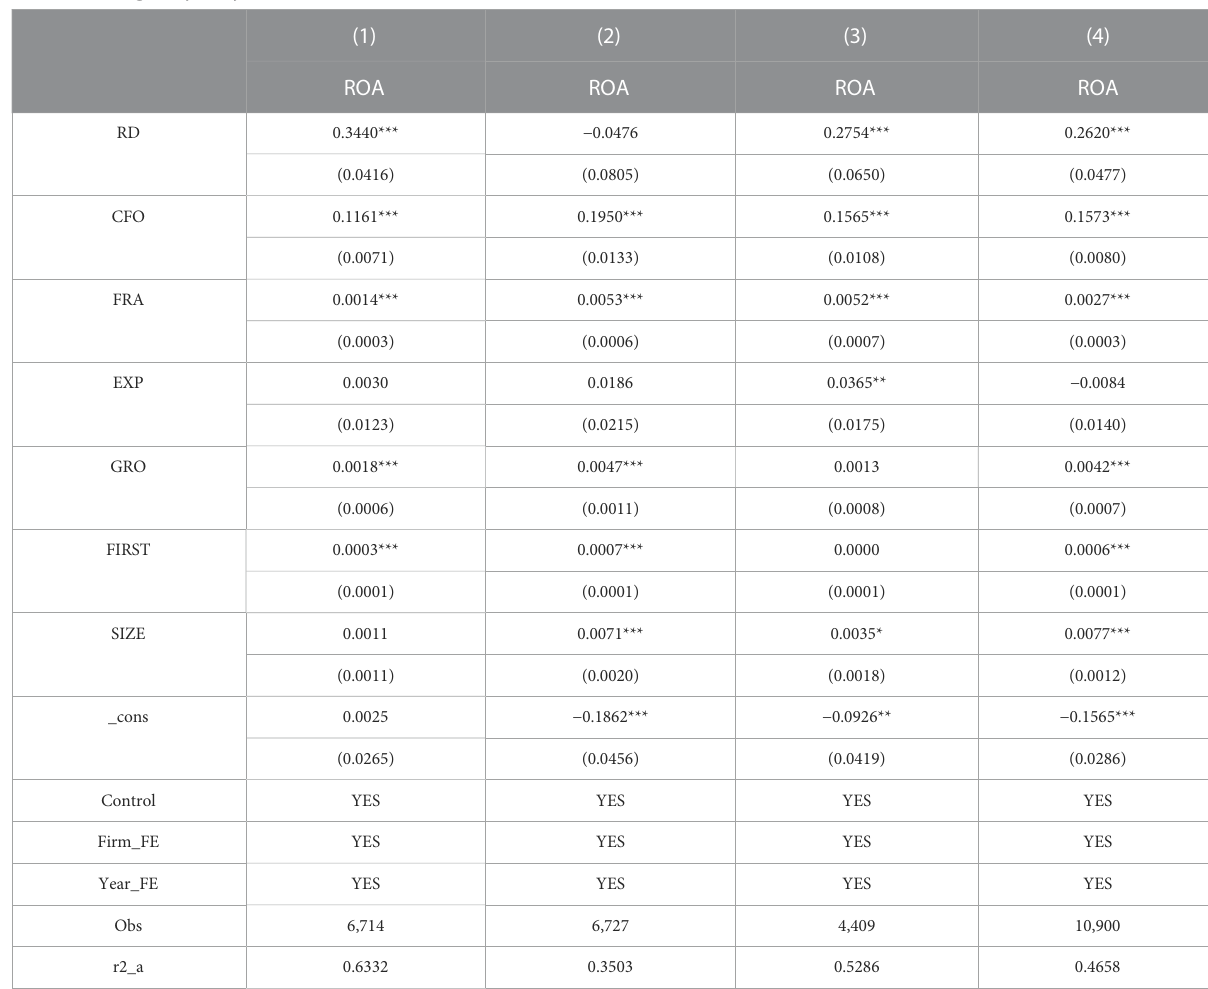
TABLE 8 Heterogeneity analysis.